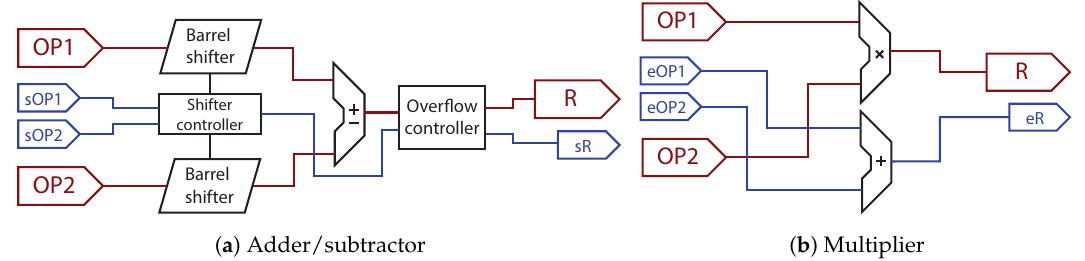
Figure 5. Adder/Subtractor and multiplier for the proposed